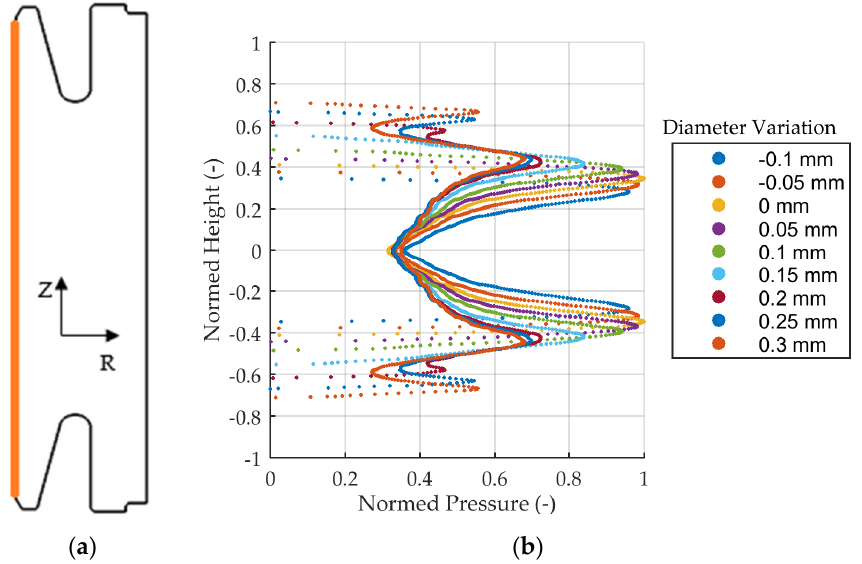
Figure 11. Pressure over height after quenching, in contact with the mandrel. ( a ) Measurement location. ( b ) Pressure over height.